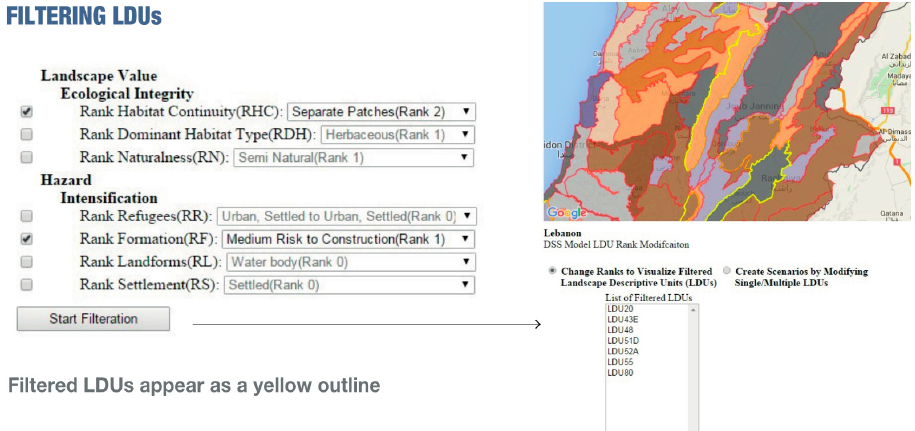
Figure 22. LDSS scenarios create by rank modification.